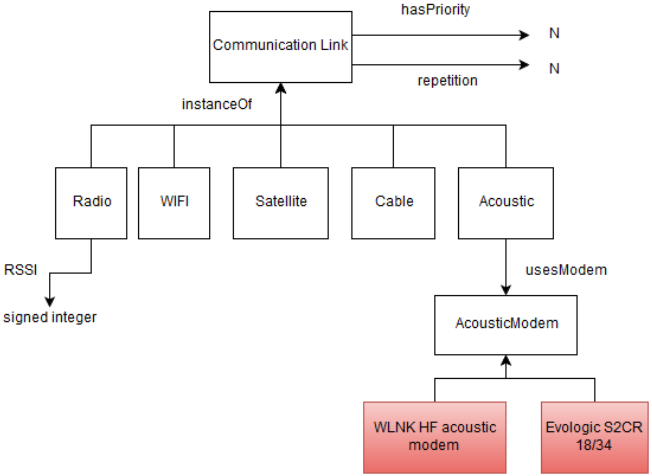
Figure 7. Communication and networking ontology.